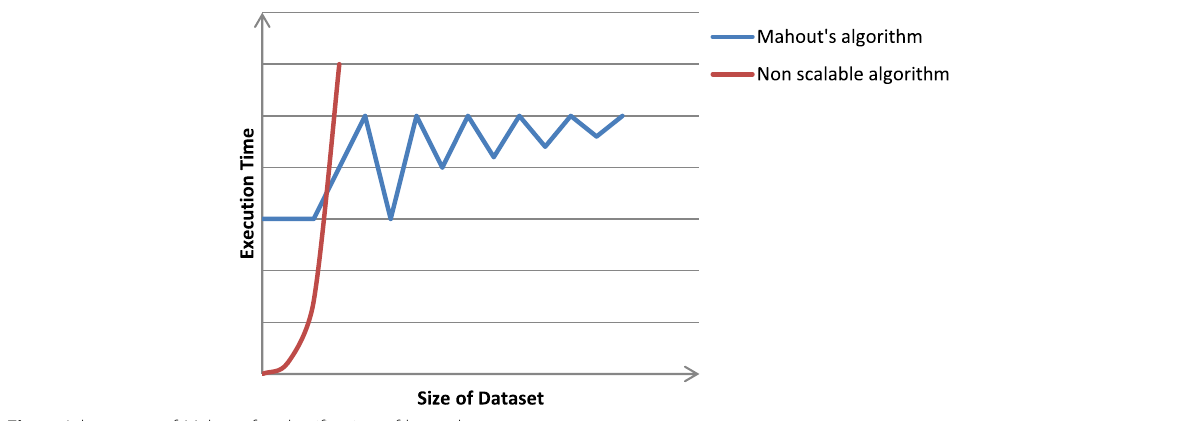
Fig. 1 Advantages of Mahout for classification of large